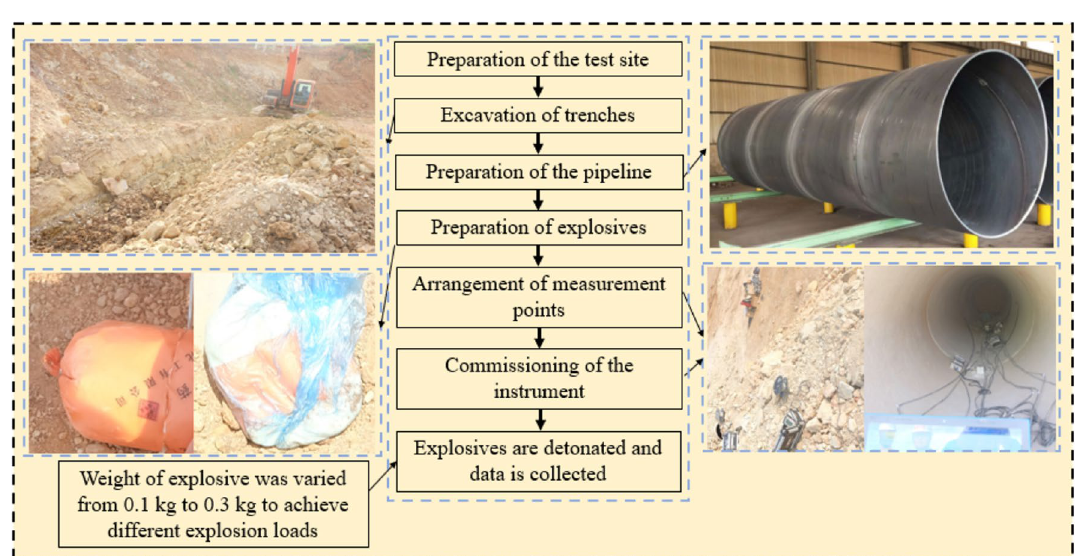
Figure 5. Procedure of the field